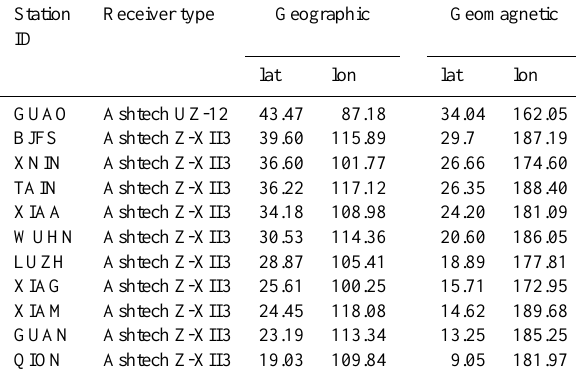
Table 1. Station ID, receiver types, geographic and geomagnetic latitude (lat) and longitude (lon) used in the